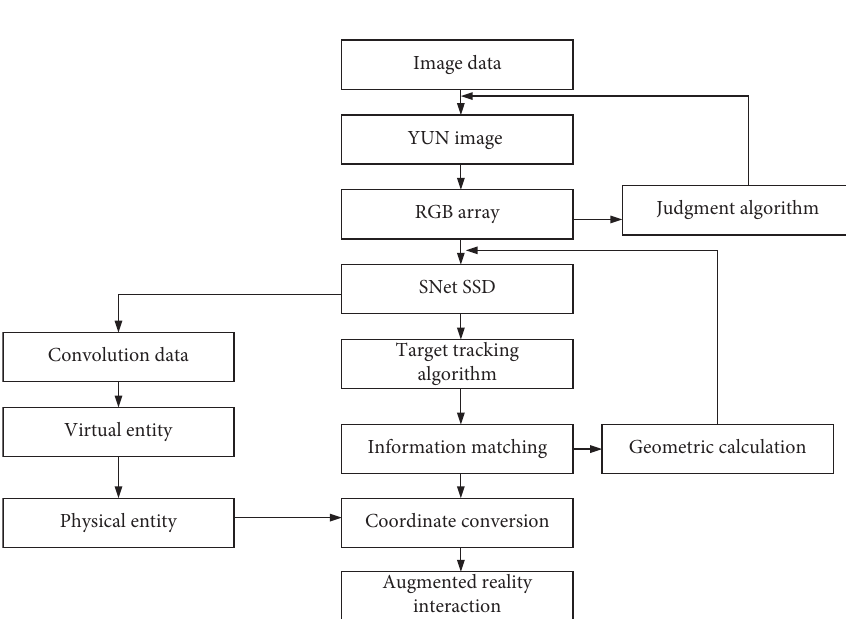
Figure 2: AR prototype system operation process.